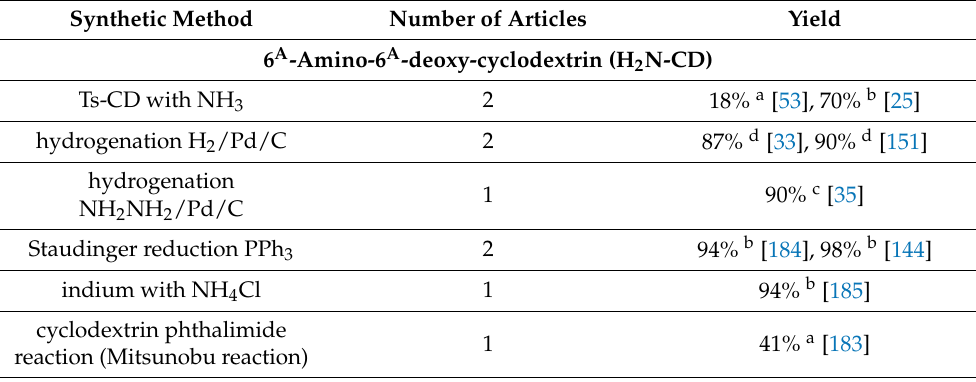
Table 8. Preparation of 6 A -amines and aryl/alkylamines of